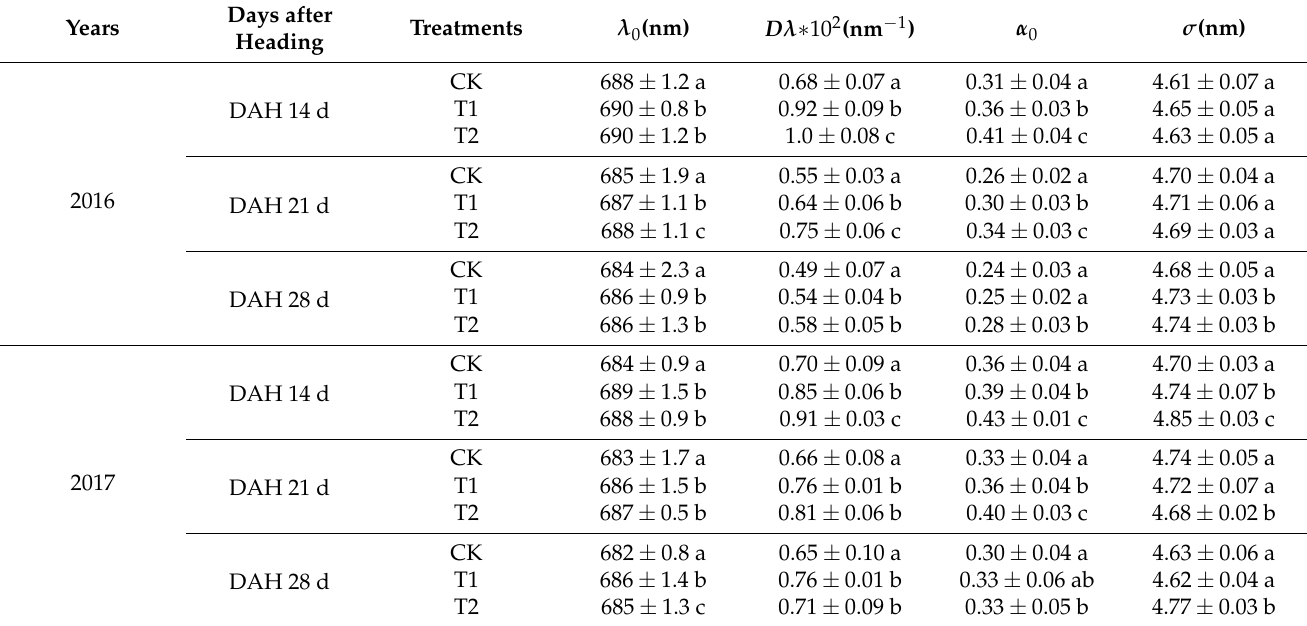
Table 5. Red-edge parameters of rice canopy spectra between different